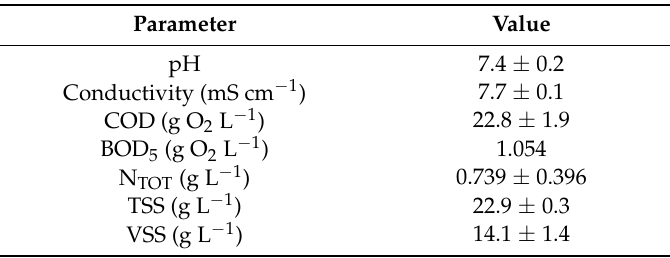
Table A2. Characterization of anaerobic sludge used for EMG-BES inoculation. Values are presented as average ± standard